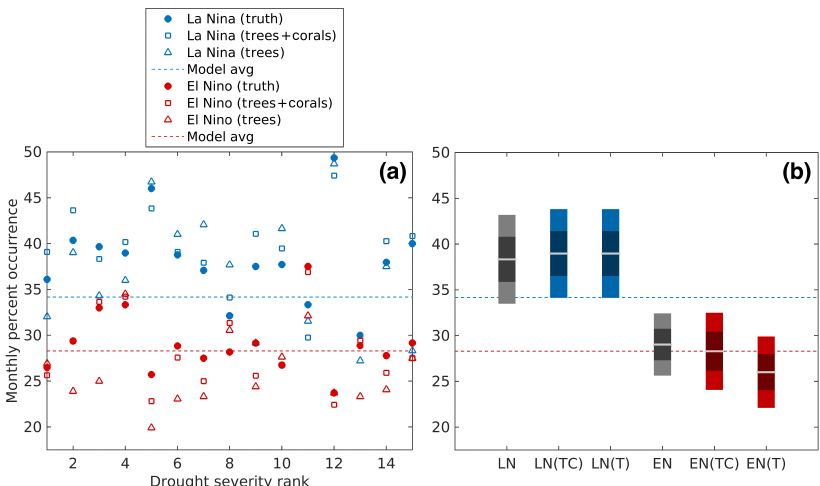
Figure 9. (a) Monthly percent occurrence of El Niño or La Niña states during the 15 most severe multiyear droughts. The occurrences are computed as a percentage of the total number of months in a given drought. Dashed lines indicate the average percent occurrence of El Niño (red) or La Niña (blue) in the CESM LME simulation 10. (b) Box plot distribution summaries of the monthly percent occurrence of El Niño or La Niña states shown in panel (a) . Light gray lines indicate the means and the darker colors indicate 1 standard deviation of the data, while the lighter colors indicate the 95% confidence intervals of the mean. The letters LN and EN stand for La Niña and El Niño, while the letters T and C indicate experiments with pseudo-trees or pseudo-corals. “LN” and “EN” by themselves are the true La Niña and El Niño occurrences (gray box plots) corresponding to the distribution of filled circles in panel (a) .